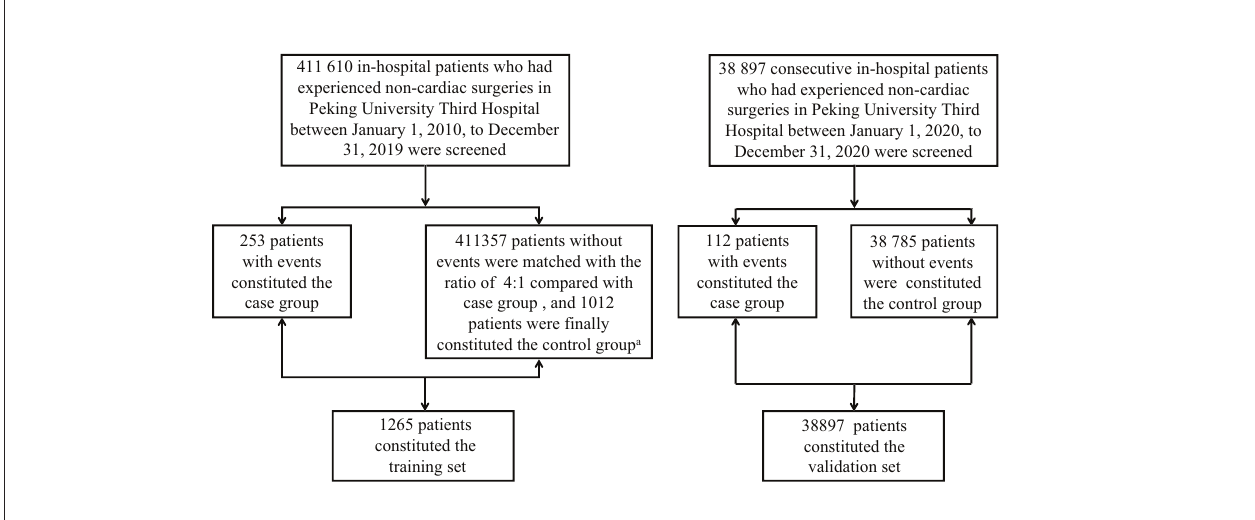
FIGURE 1 | Patients screening process of training set and validation set. a: The patients were matched according to the type of operation, operative time and age with the ratio of 4:1 between non-events group and events group. The matched patients belonged to one same operation type which was demonstrated in Supplementary Table 1 in Supplemental Appendix , while they were randomly selected in patients who had operation one month before or after the patients in events